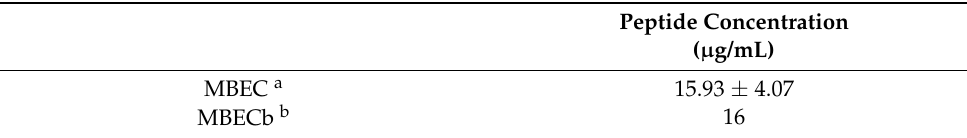
Table 4. Antibiofilm activity of Q4-15a-1 against MDR